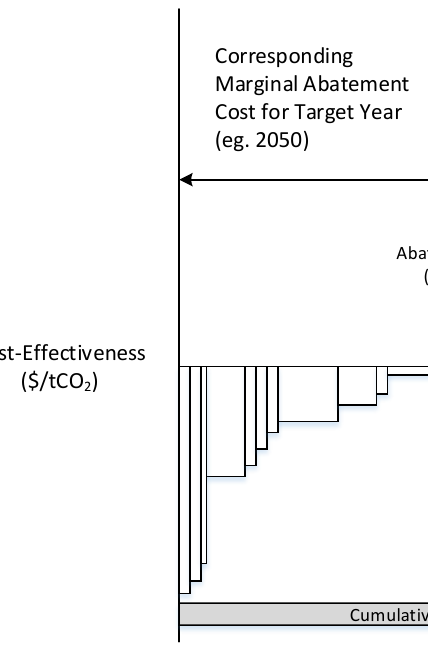
Figure 3. Marginal Abatement Cost (MAC) curve components.